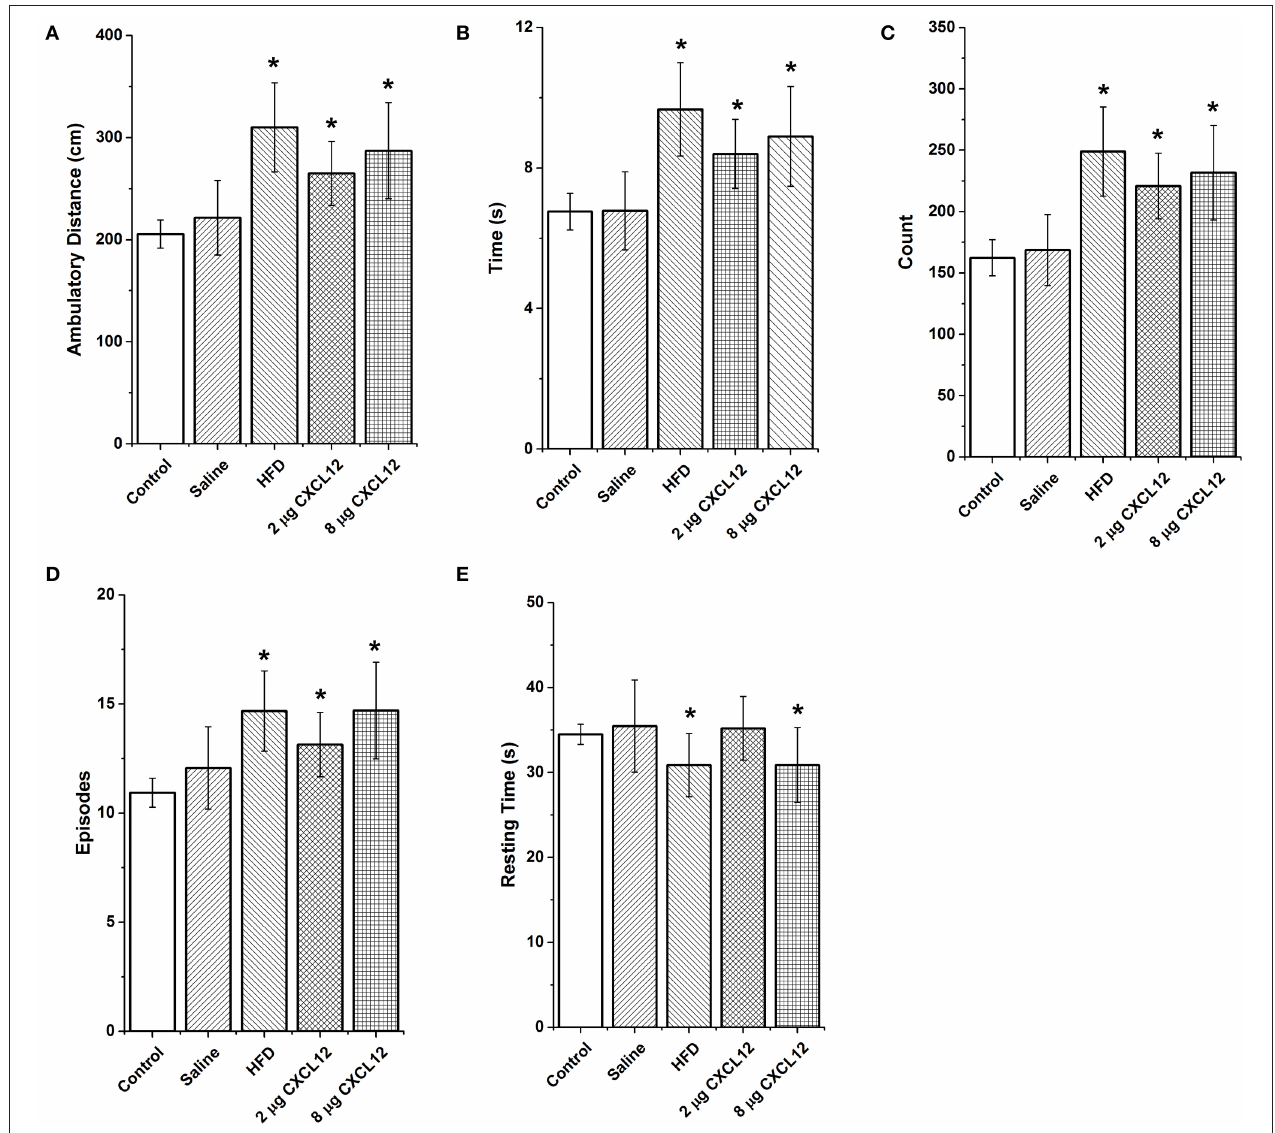
FIGURE 6 | Prenatal HFD and CXCL12 similarly increase locomotor activity in a novel environment. Prenatal exposure to a HFD or CXCL12 at 2 or 8 µ g compared to control significantly increases locomotor activity as measured by (A) ambulatory distance; (B) ambulatory time; (C) ambulatory counts (number of infrared beam breaks); and (D) ambulatory episodes. (E) A decrease in resting time was found in the prenatal HFD and 8 µ g CXCL12 offspring but not the 2 µ g CXCL12 as compared to control offspring. * p < 0.05 vs.